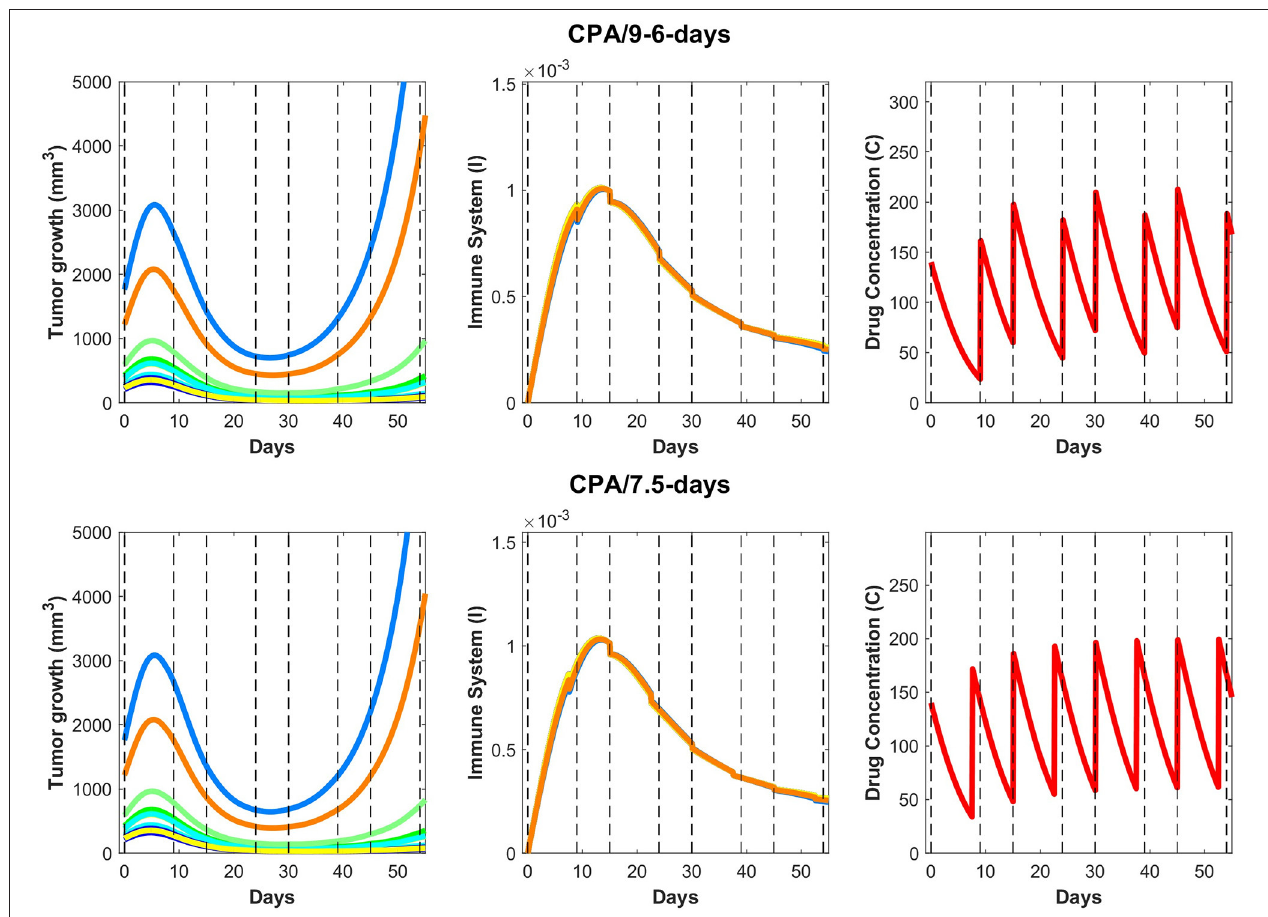
FIGURE 7 | On the (top) row, predictions for the CPA/9-6-days drug regimen where the first break is 9 days followed by 6 days, then 9, then 6 and so on, alternatively. On the (bottom) row, similar predictions are made for